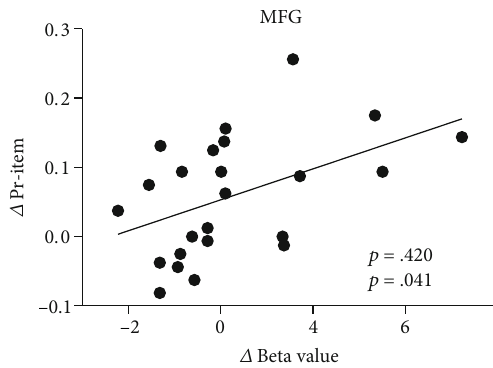
Figure 5: Correlation between the change in brain activity of the left middle frontal gyrus (MFG) and the change in item memory performance in the anodal transcranial direct current stimulation (atDCS) group. Each dot represents data from one participant. The regression line indicates a positive